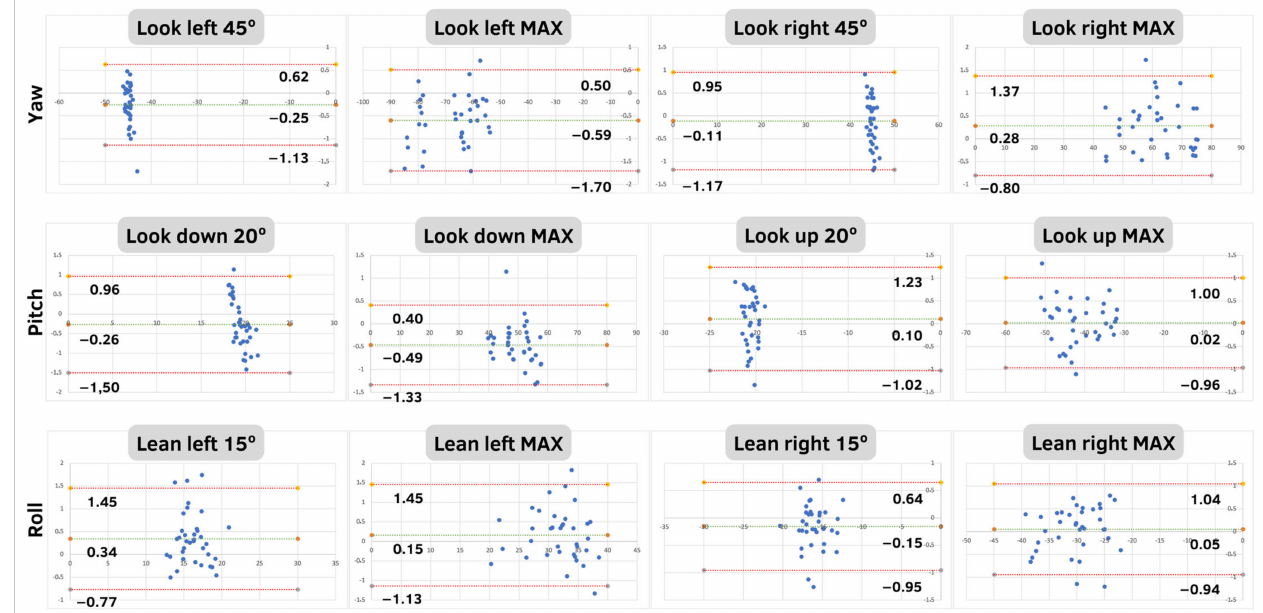
Figure 4. Bland–Altman plots to assess the agreement between HMD system and the IMU in all the positions and axes. The plots include the mean difference (green line) and limits of agreement (red